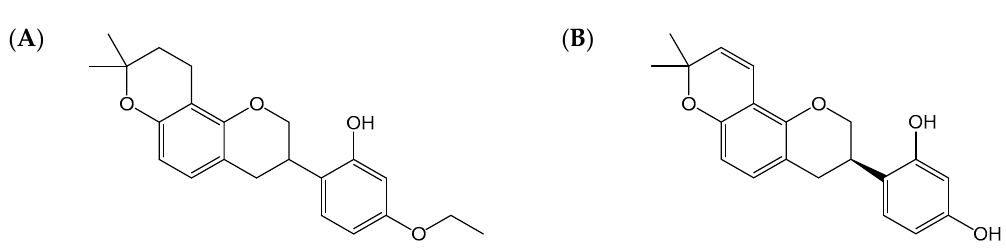
Figure 1. Chemical structures of ( A ) HSG4112 and ( B ) glabridin.